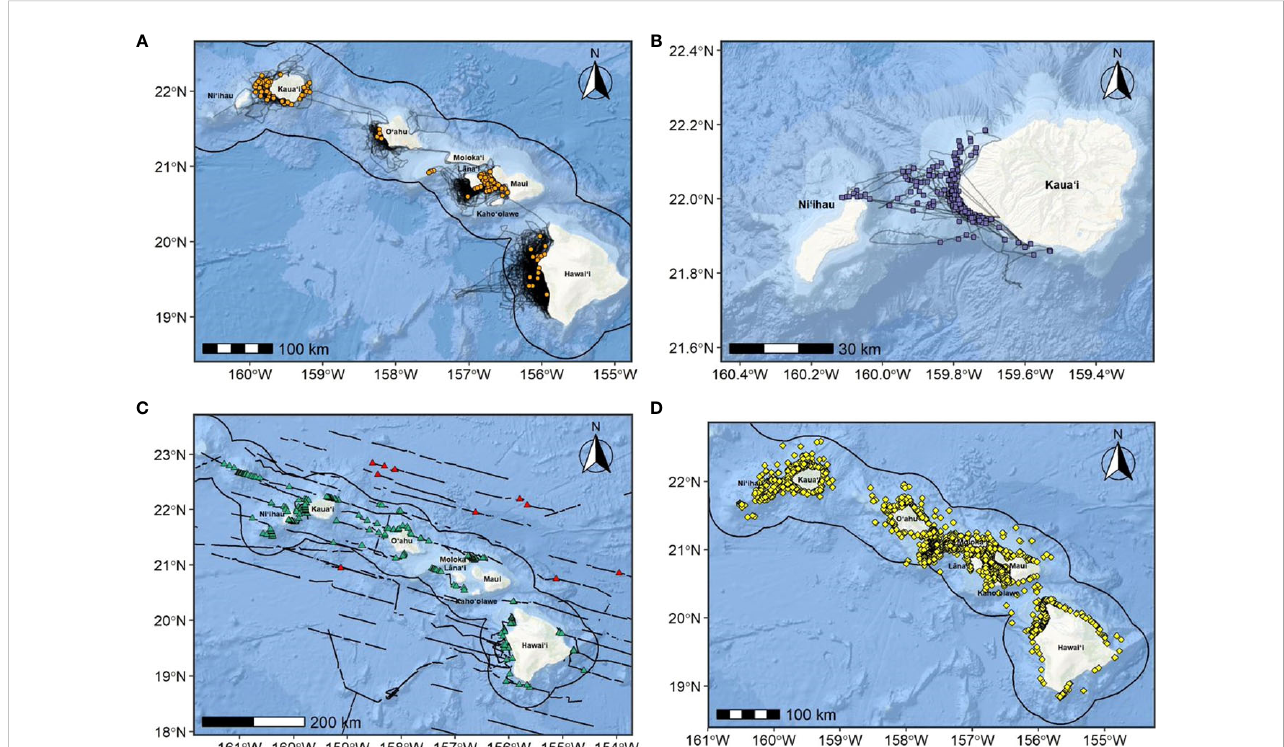
FIGURE 6 Humpback whale sighting locations overlaid on research vessel tracklines from (A) CRC during small boat surveys from 2000-2021 (orange circles; n=199); (B) NIWC Paci fi c and HDR, Inc. during small boat surveys from 2017-2019 (purple squares; n=202); (C) NMFS during ship-based line-transect surveys from 2002-2020 (green triangles; n=213; red triangles are sightings outside the MHI breeding area perimeter and excluded from BIA, n=11); and (D) MMRC aerial surveys from 1993-2003 (yellow diamonds, n=2,297; see Mobley et al., 2001; Mobley, 2004 for effort tracklines). The MHI breeding area perimeter considered in this revised assessment is shown as a solid black outline around the islands; only data collected within the perimeter boundary and around the main Hawaiian Islands were included in this revised assessment. Basemap image is the intellectual property of Esri and is used herein with permission. Copyright © 2022 Esri and its licensors. All rights